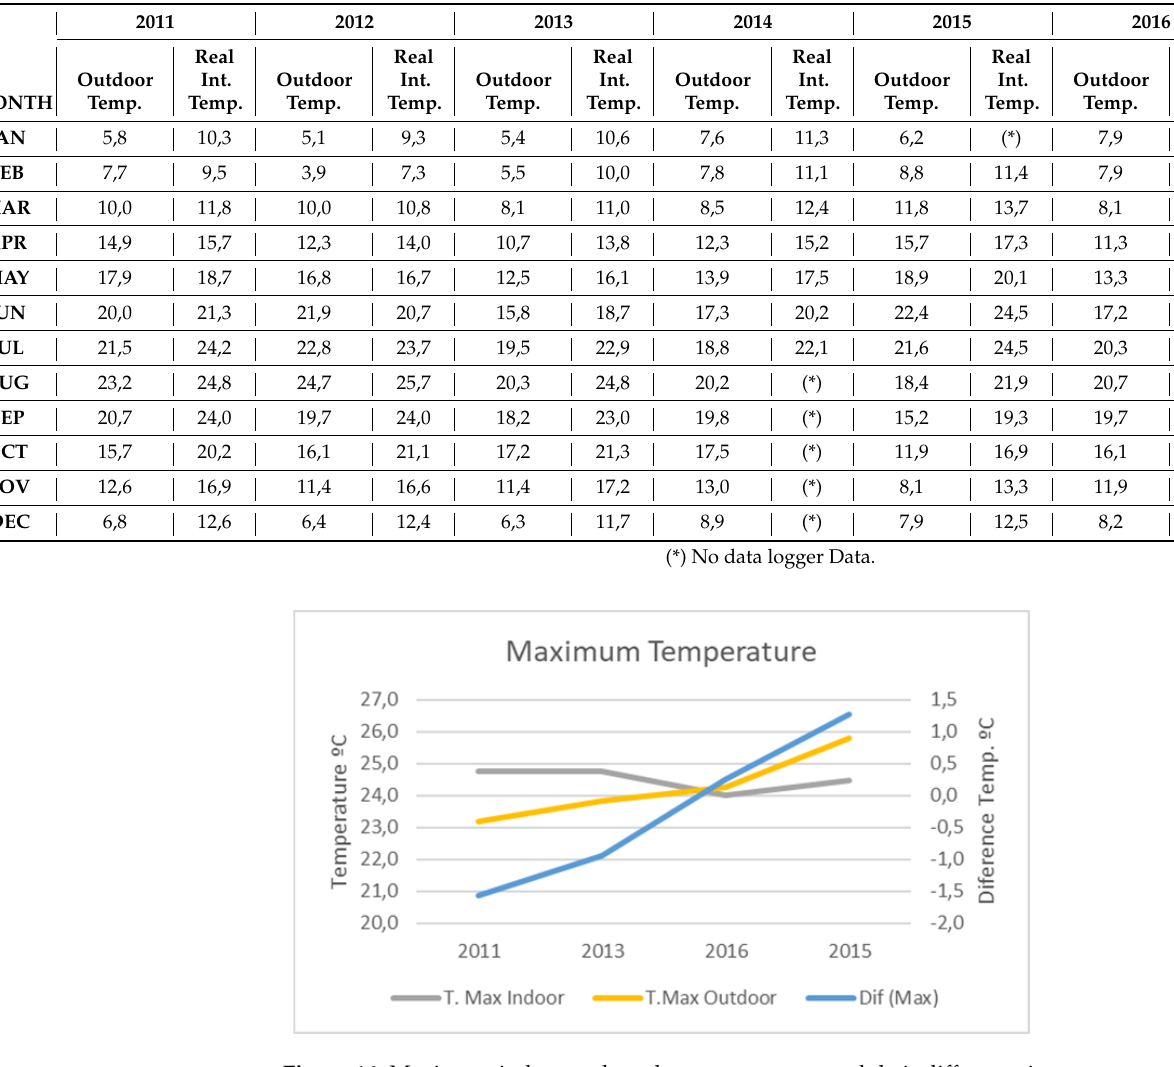
Table 6. Comparison of outdoor and real indoor temperatures for different years.